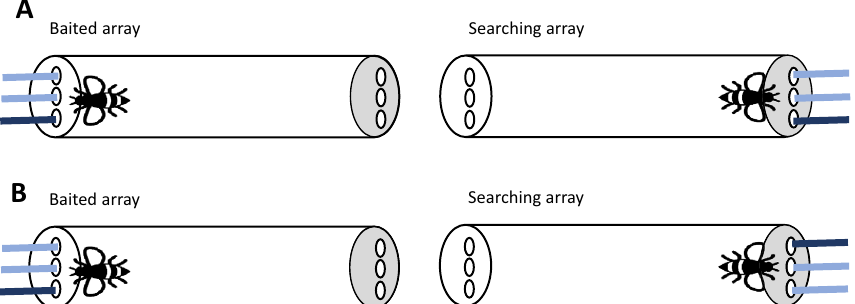
Figure 1. Bird’s eye view of the experimental setup for Experiments 1–3. Bees experience one of the three paper strips baited on the transparent side (Baited array), and they had to search among the strips on the opaque side (Searching array). All the stimuli were identical. Note that the darker blue colour has only been used to represent an Allocentric searching strategy ( A ) and an Egocentric searching strategy ( B